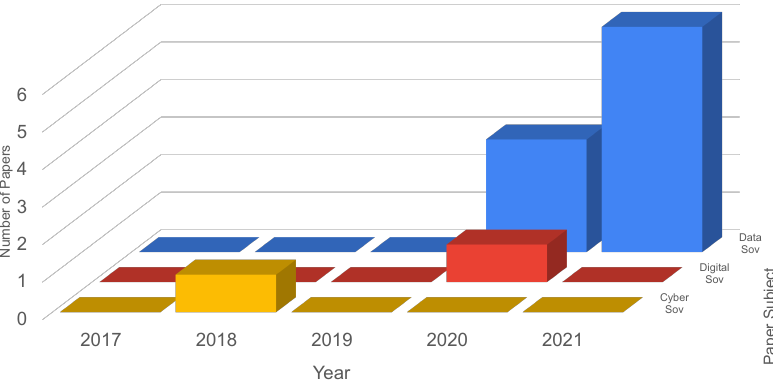
Figure 4. Data sovereignty, digital sovereignty and cyber sovereignty papers